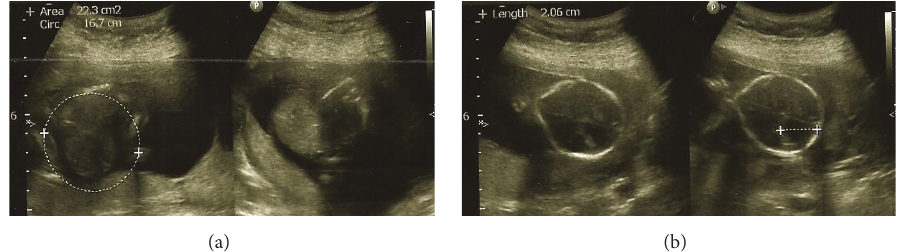
Figure 1: The image of the prenatal ultrasound scan. (a) The omphalocele sac (arrowhead) containing the liver and bowels. (b) The lemon sign (arrowhead).